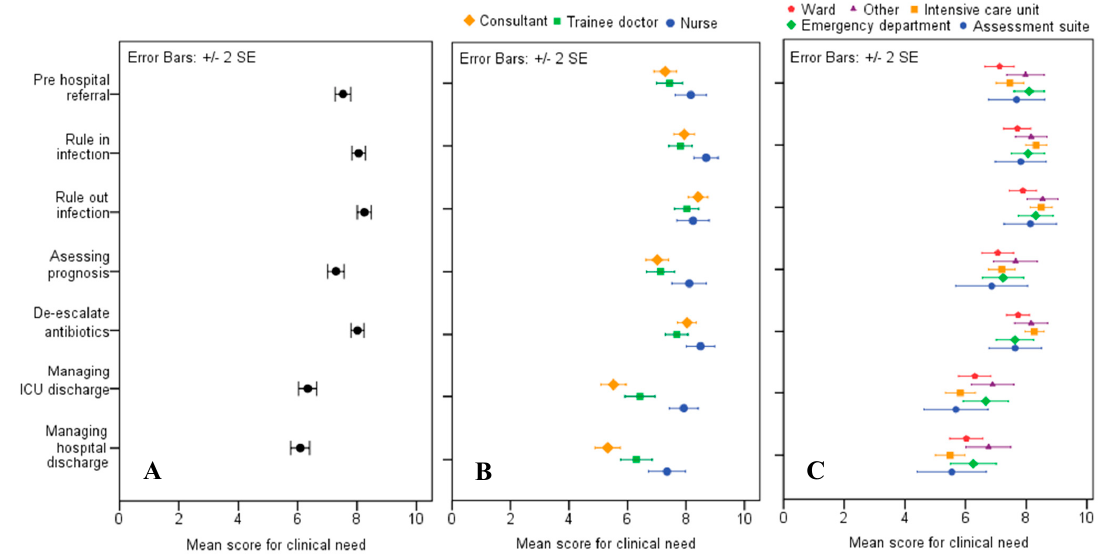
Figure 1. Scores of clinical need for a novel test in seven di ff erent clinical scenarios. ( A ) Overall mean scores for clinical need for seven di ff erent clinical scenarios. ( B ) Mean scores for clinical need for categorised by job role. ( C) Mean scores for clinical need categorised by hospital section.